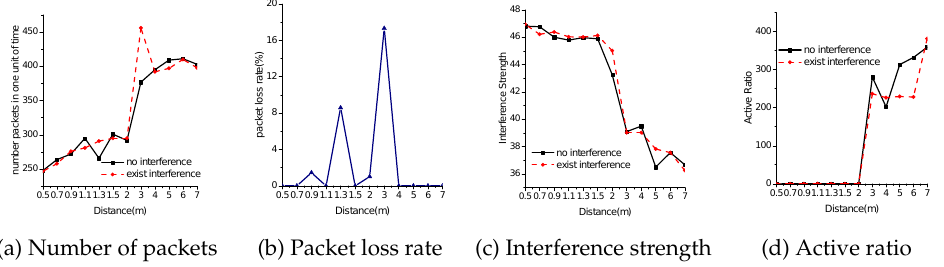
Figure 10. Four parameters under different